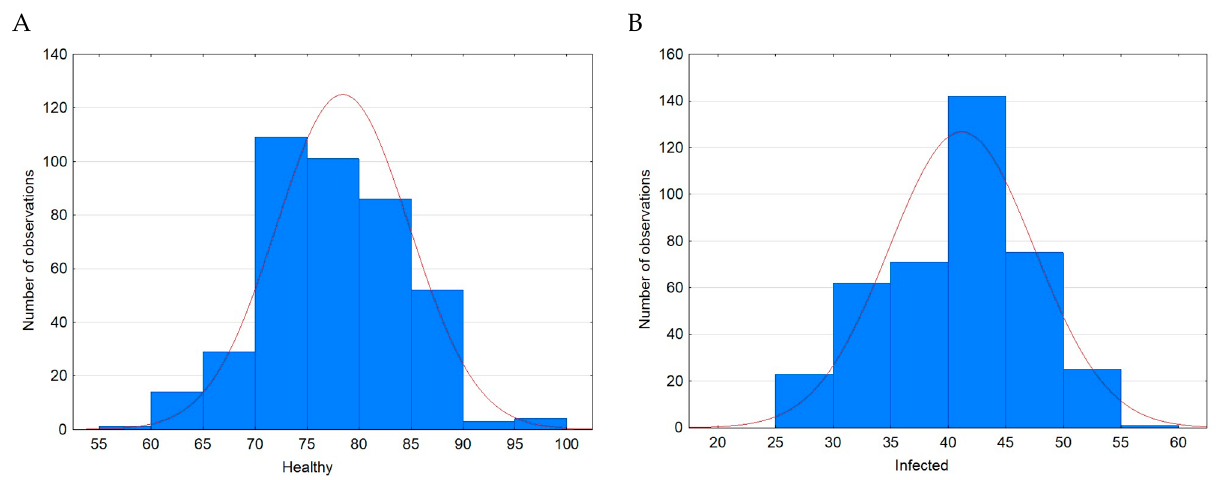
Figure 2. The number of live cell observations in the given ranges of the tested number of live cells for healthy ( A ) and infected ( B ) honeybees. The X-axis shows the intervals related to the designated number of cells obtained in each examined image.